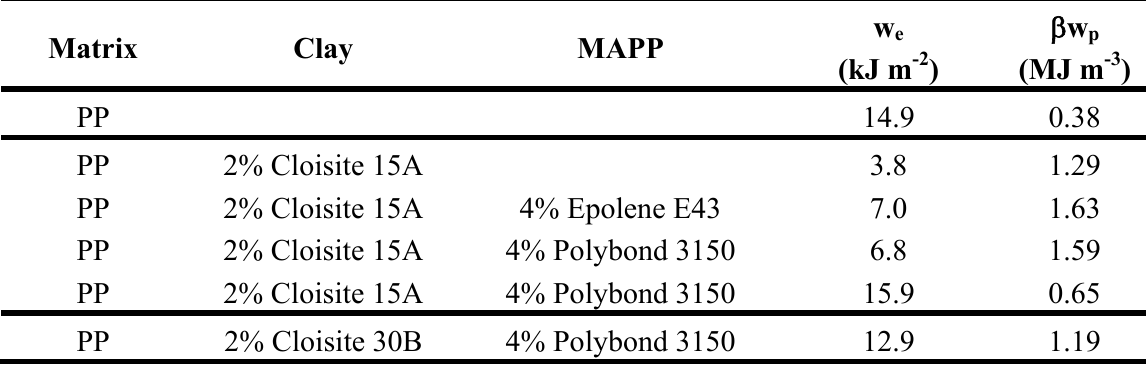
Table 8. EWF parameters of PP nanocomposites with differences in the interfacial adhesion between phases (adapted from